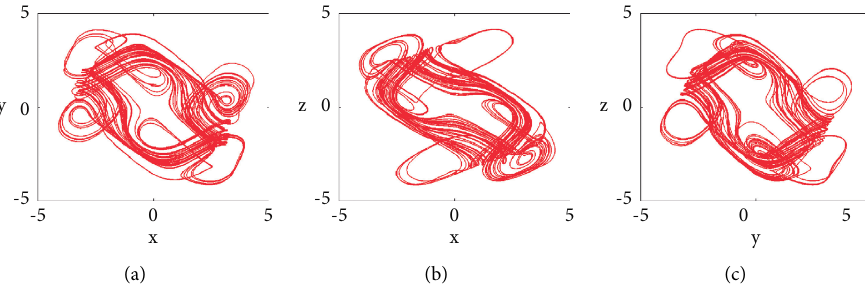
Figure 7: Chaotic attractor of system (4) when q ,y ,z ) � (− 1 , 1 , 1 ) on (a) xy plane, (b) xz plane, and (c) yz plane. ( x 0 0 0